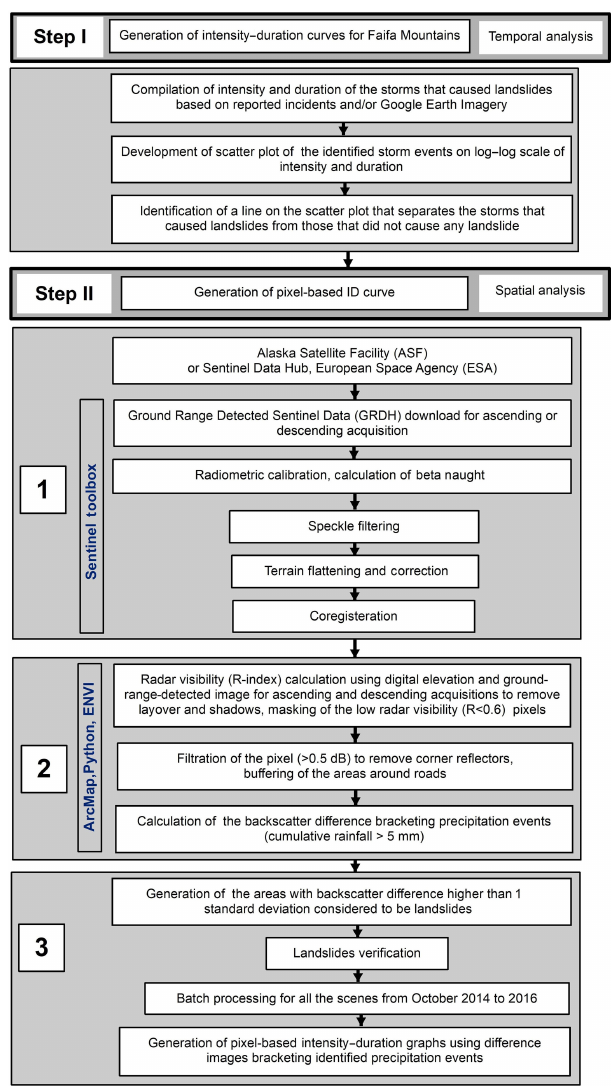
Figure 3. Flow chart summarizing the developed methodology that could serve as important steps towards the construction of an EWNSL. The developed procedures involved the analysis of tempo- ral Google Earth images, Sentinel-1A radar scenes, and TRMM and GPM rainfall data. Analysis involved two main steps: generation of an ID curve for the Faifa Mountains to identify storms that are likely to produce landslides (landslide-producing storms), and generation of pixel-based ID curves to identify the locations where movement is likely to occur during landslide-producing storms. Step II in- volved (1) selection, calibration, and preprocessing of radar images, (2) generation of backscatter coefficient difference images as a mea- sure of surface roughness change due to precipitation-induced land- slides, and (3) development, refinement, and validation of the model to identify pixels susceptible to movement under user-defined pre- cipitation conditions. The downloaded scenes were processed using the ESA’s Sentinel Toolbox software, ENVI, ArcMap, and